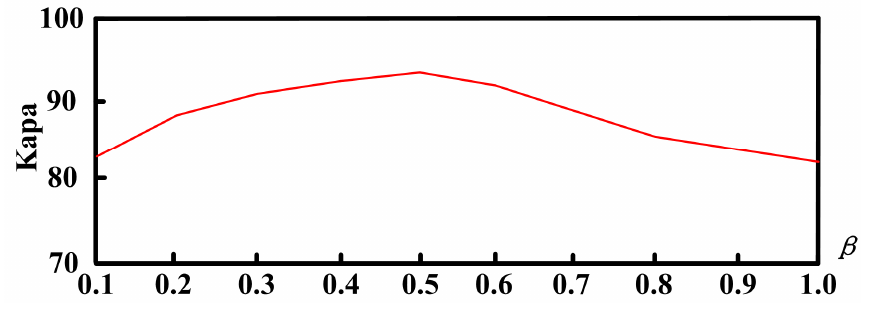
Figure 14. Kapa curve of β .